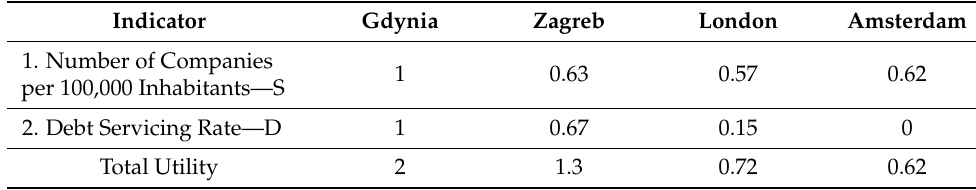
Table 3. Partial and total utility for the economic dimension indicators.